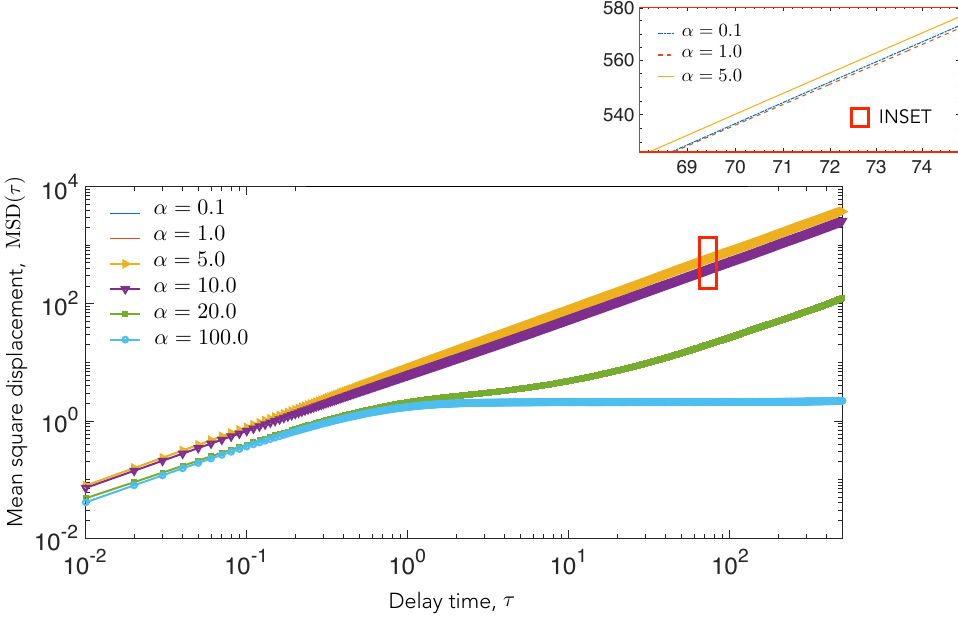
Figure 5. Mean square displacement (MSD) as a function of the delay time interval τ (calculated from Equation (9)), for the motile cell A is shown. Here we explore the variation in the MSD for various values of substrate-mediated elastic interactions, α . The diffusivity D T is held constant for these simulations with D T = 2. Other diffusivities were explored (results not shown). At low elastic interaction strengths, α , corresponding to stiff substrates, the cell shows a purely diffusive trajectory, whereas at higher values of α , the motile cell is captured by the strong attractive interaction from the stationary cell, resulting in a flattening of the MSD (blue curve). At an intermediate interaction regime (green curve), the motile cell makes repeated contact with the fixed cell, but it is never fully